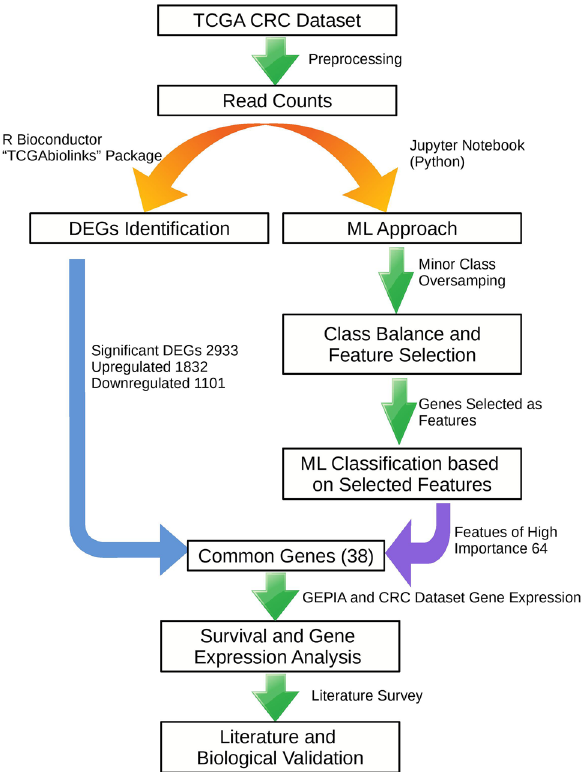
Figure 1. Workflow for the identification of novel biomarkers for colorectal cancer. TCGA: The Cancer Genome Atlas; CRC: colorectal cancer; DEGs: differentially expressed genes; ML: machine learning; GEPIA: gene expression profiling interactive